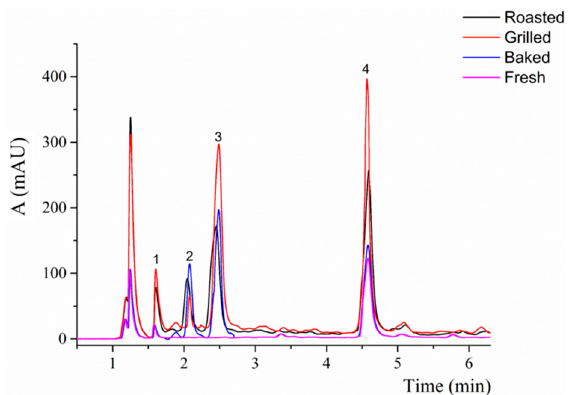
Figure 2. Optimized chromatographic separation of chlorogenic acid and other compounds before and after thermal processing of eggplant. 1—(dihydrocoumaroyl glucoside) amide isomer, 2— N -caffeoylputrescine isomer, 3—5-hydroxymethylfurfural, 4—chlorogenic acid.